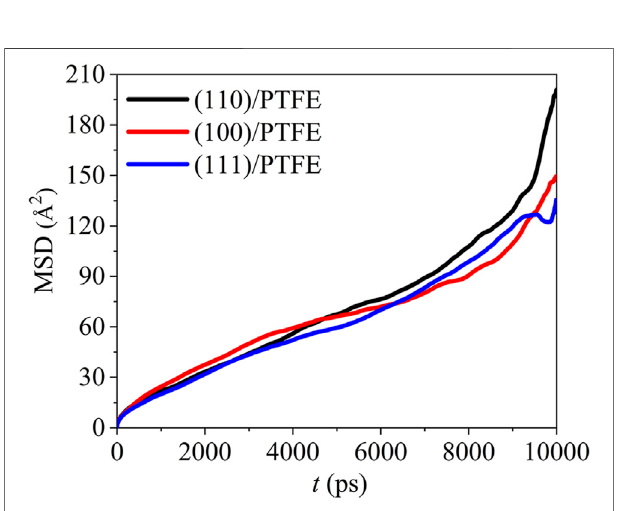
FIGURE 5 | Mean square displacement of PTFE molecule in the (100)/ PTFE (110)/PTFE, and (111)/PTFE interface systems.